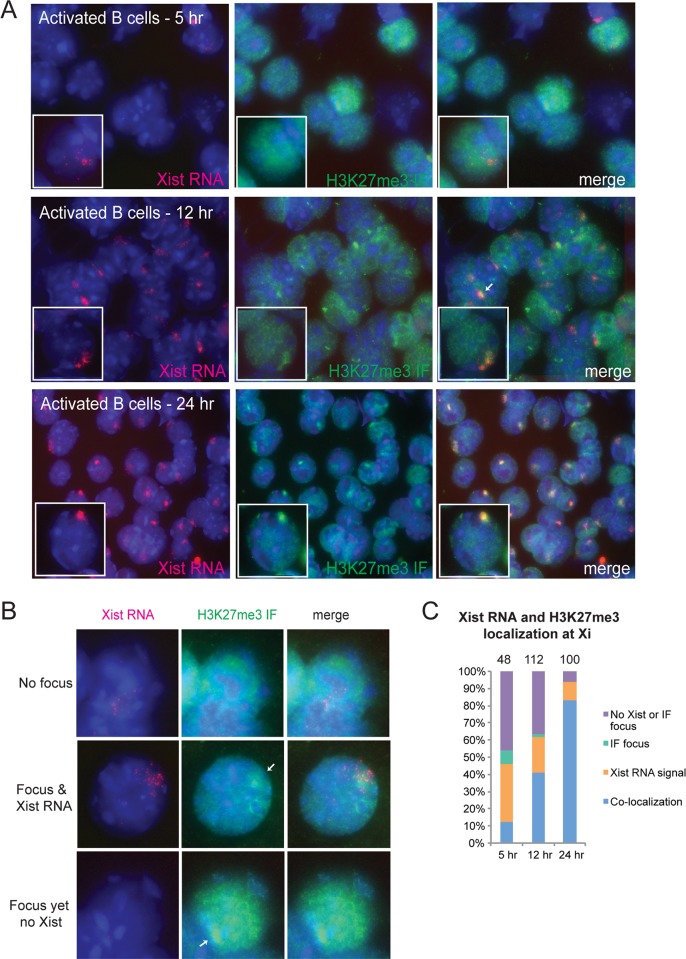
Simultaneous return of Xist RNA and H3K27me3 enrichment at the Xi during B cell activation.(A) Sequential Xist RNA FISH (red) then immunofluorescence detection (green) for H3K27me3 at 5, 12, 24 hrs post-stimulation. Representative results from one experiment (#1) are shown; results from experiments #2, 3 are shown in S8 Fig. One-way ANOVA analyses comparing all three experiments were not statistically different. (B) Examples of individual nuclei displaying different co-localization patterns of Xist RNA (red) and Xi heterochromatin (H3K27me3, green); taken 5 hrs post-stimulation. White arrows denote heterochromatic foci. (C) Quantification of co-localization patterns for Xist RNA and H3K27me3 (blue bars), Xist RNA signals alone (orange), H3K27me3 foci alone (green), or nuclei without either signals (purple) during B cell stimulation. Xist RNA signals corresponded to Type I, II, or III patterns. Results from one experiment are shown; three independent experiments were performed and these results are shown in S8 Fig together with statistical tests across all three independent replicates. The total number of nuclei counted is shown above each column.